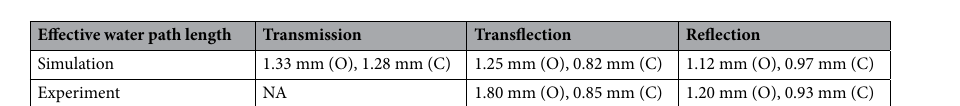
Table 2. Effective water path length comparison between simulation and experiment for each optical configuration.